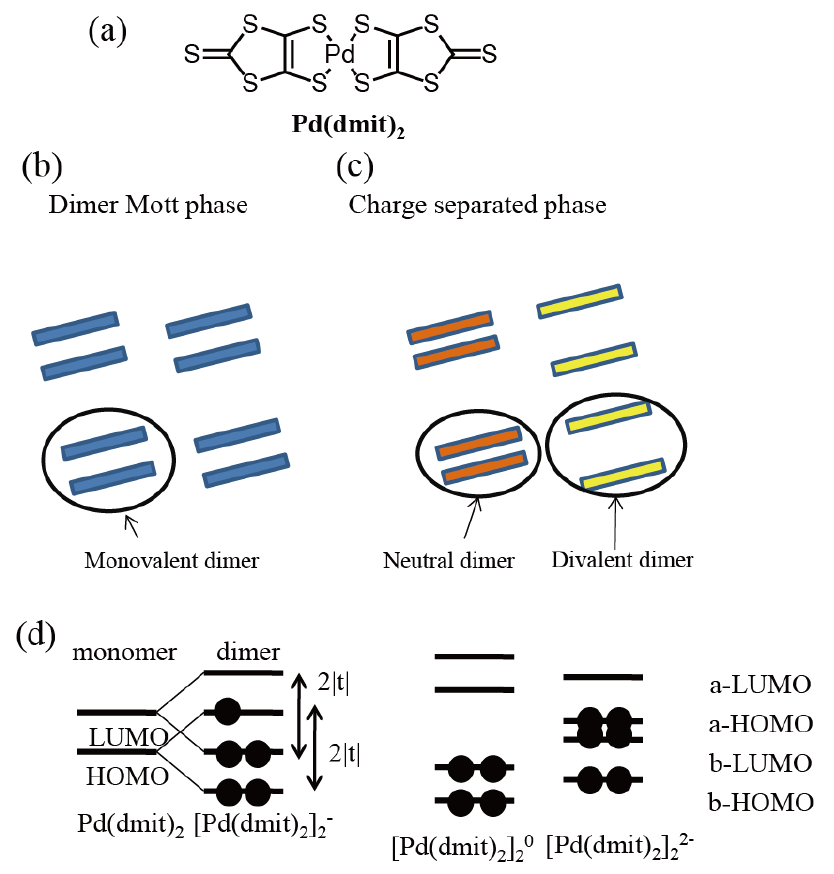
; ( b ) Schematic of crystal structure of 2 Me Sb[Pd(dmit) ] on Pd(dmit) plane; 2 2 2 2 2 2 molecules viewed along molecular 2